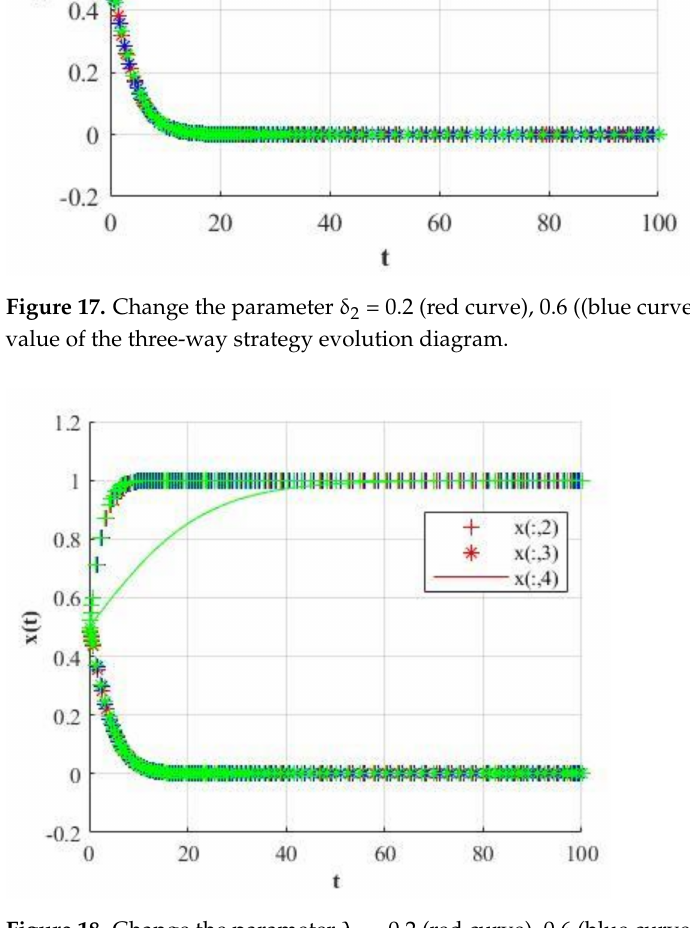
Figure 18. Change the parameter λ 1 = 0.2 (red curve), 0.6 (blue curve), 0.9 (green curve) to take the value of the three-way strategy evolution